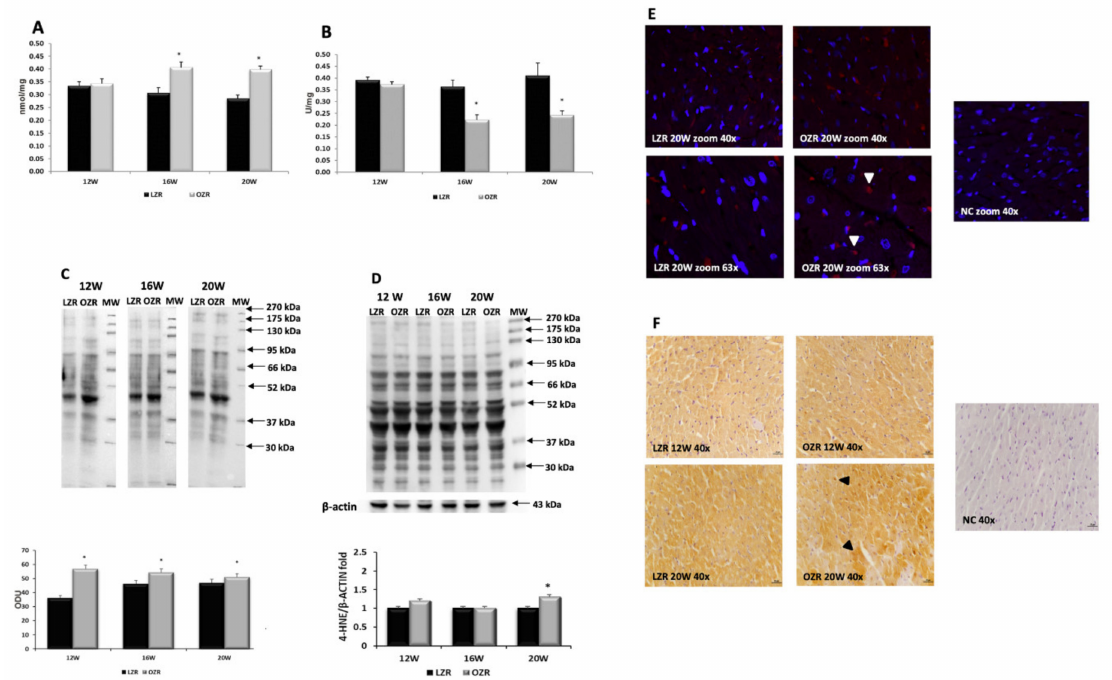
Figure 2. Oxidative stress in heart. ( A ) Concentration of thiobarbituric acid reactive substances (expressed in nmol / mg of tissue); ( B ) superoxide dismutase specific activity (expressed as U / mg of proteins where one unit is the amount of enzyme needed to exhibit 50% dismutation of the superoxide radical) in heart tissue of lean Zucker rats (LZR black bar) and obese Zucker rats (OZR grey bar) at the age of 12, 16, and 20 weeks (X axis); ( C ) lysates of heart from LZR and OZR rats were immunoblotted using the OxyBlot kit. Bar graph reports the values of optical density measured in optical density unit (ODU). Data are mean ± S.E.M. * p < 0.05 vs. age-matched LZR; ( D ) lysates of heart from LZR and OZR rats were immunoblotted using specific anti 4-Hydroxynonenal (4-HNE). Values indicate the ratio of densitometric analysis of bands and β -actin levels used as loading control, considering LZR group as reference. Blots are representative of one of three separate experiments; ( E ) sections of the heart of 20 weeks old LZR and OZR were processed for the immunohistochemistry of 8-oxo-dG at the magnification 40 × zoom and 63 × zoom. The immunoreaction is present more in the cytoplasm than nuclei of cells (arrow heads). NC: negative control; ( F ) sections of the heart of 12 and 20 weeks old LZR and OZR were processed for the immunohistochemistry of 4-HNE at the magnification 40 × . The cardiomyocytes that are more immunoreactive are indicated with the arrow heads. NC: negative control. Calibration bar 25 µ